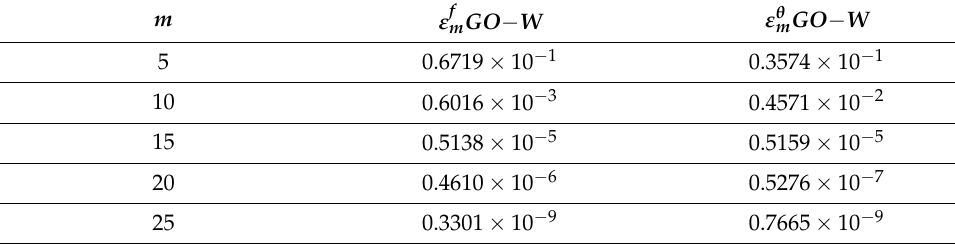
Table 6. Convergence method for GO − W